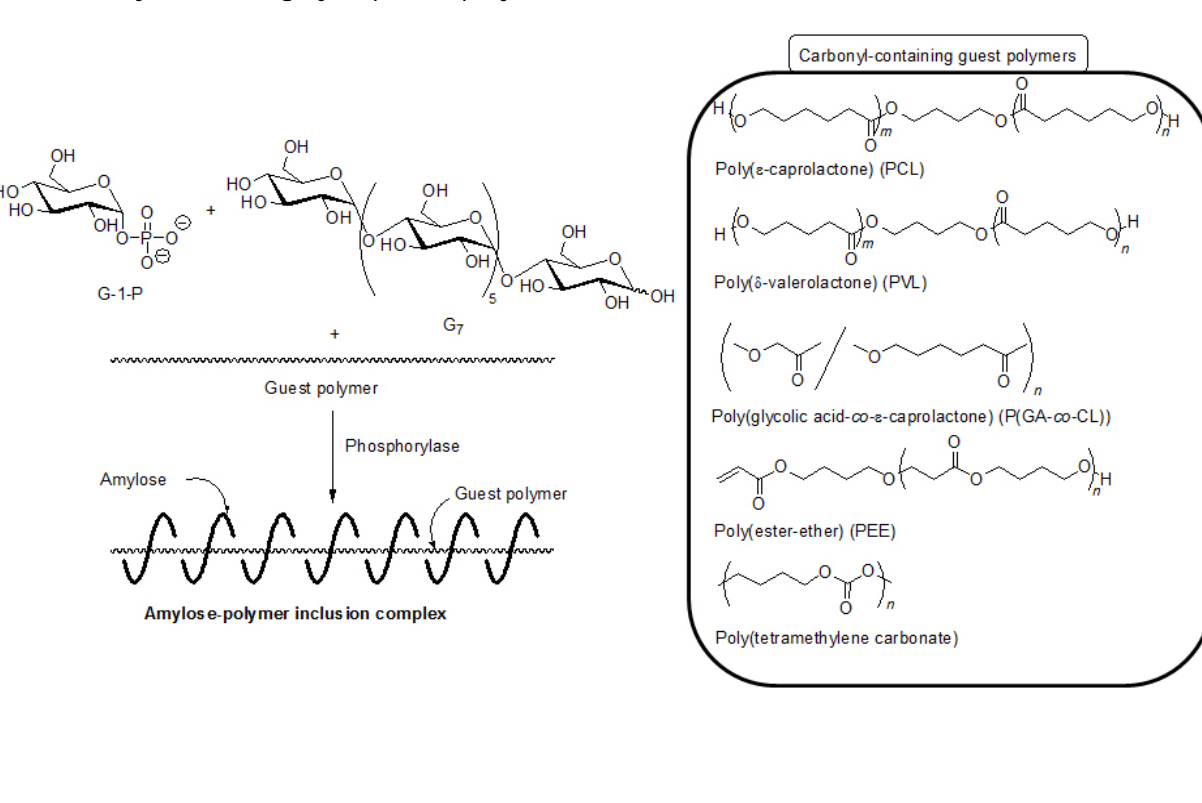
Figure 7. Architecture of inclusion complexes by vine-twining polymerization using carbonyl-containing hydrophobic